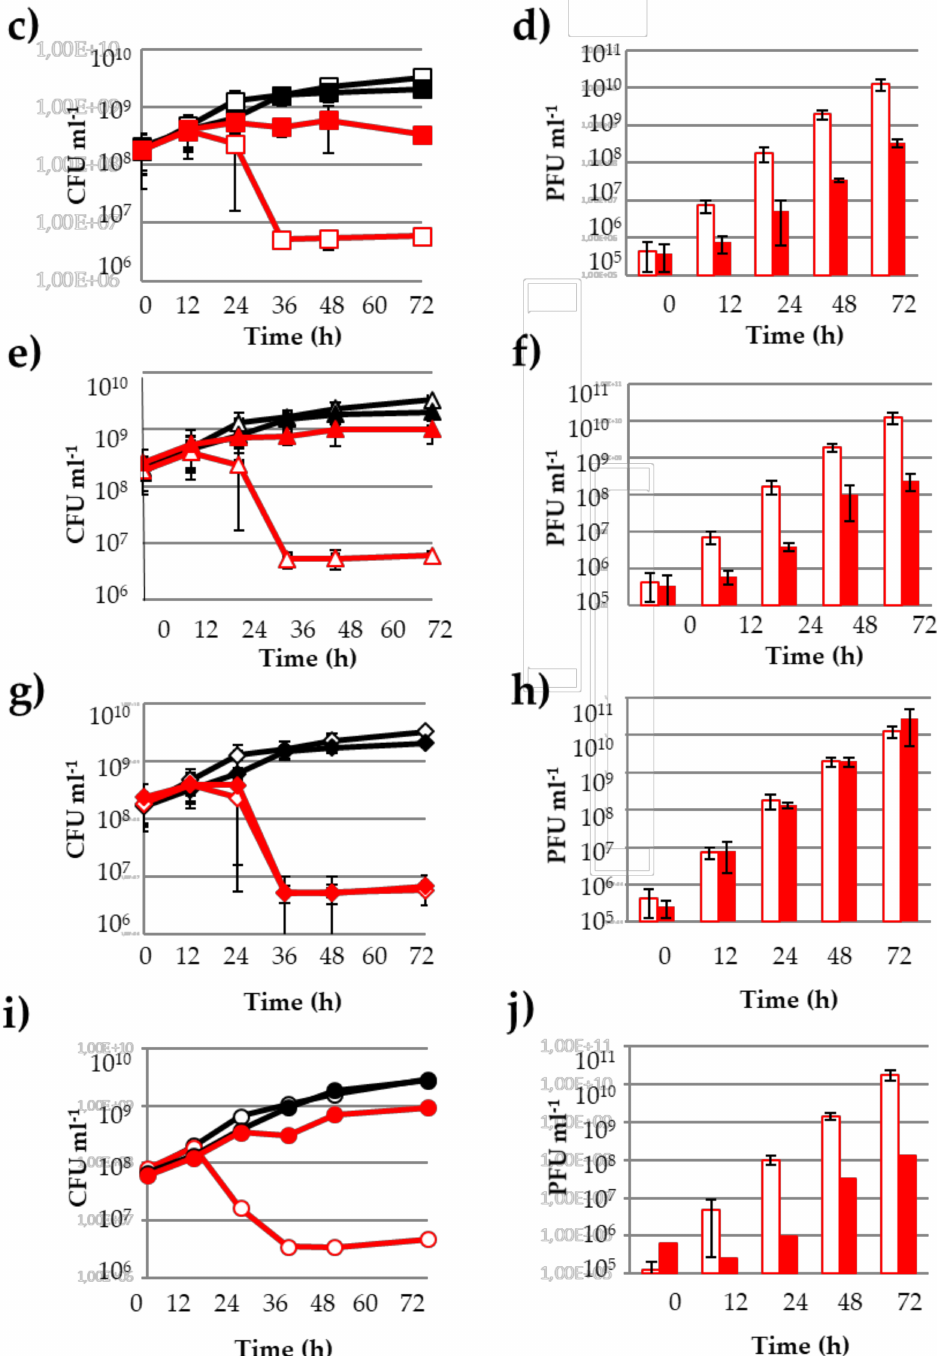
Figure 2. The e ff ect of pure phenolic compounds on the infection cycle of OE33PA on O. oeni IOEBS277. ( a , b ) p -coumaric acid; ( c , d ) quercetin; (e , f ) myricetin; ( g , h ) trans-resveratrol (cis-resveratrol yielded similar results) and ( i , j ) morin. Infected and non-infected cultures are in red and black, respectively. Controls without phenolic compounds are indicated with an empty mark. Filled marks represent cultures where 50 µ g mL − 1 of phenolic compounds were added. ( a , c , e , g , i ) represent bacterial growth curves (CFU mL − 1 ) and ( b , d , f , h , j ) represent free phages in the supernatant (PFU mL − 1 ). Experiments were done in